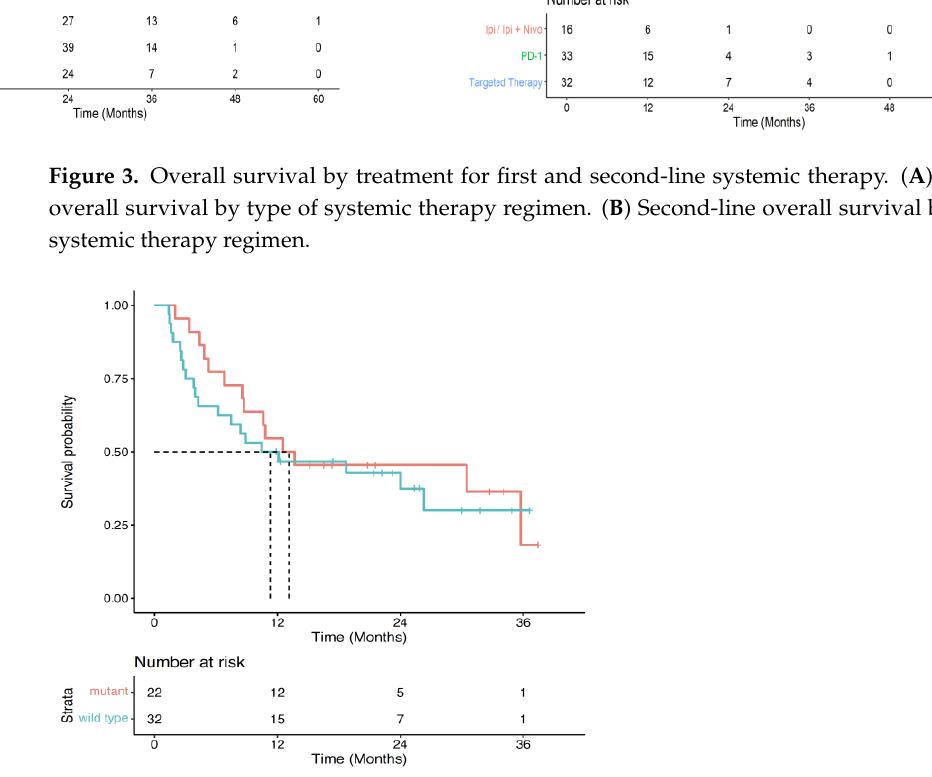
Figure 4. Overall survival by treatment for first-line systemic therapy by BRAF status.